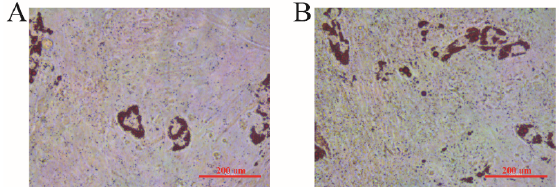
Figure 3. Oil red O staining when overexpressing the PDGF-D gene in sheep preadipocytes after 7 days of induced differentiation. ( A ) Control group. ( B ) PDGF-D overexpressed group.